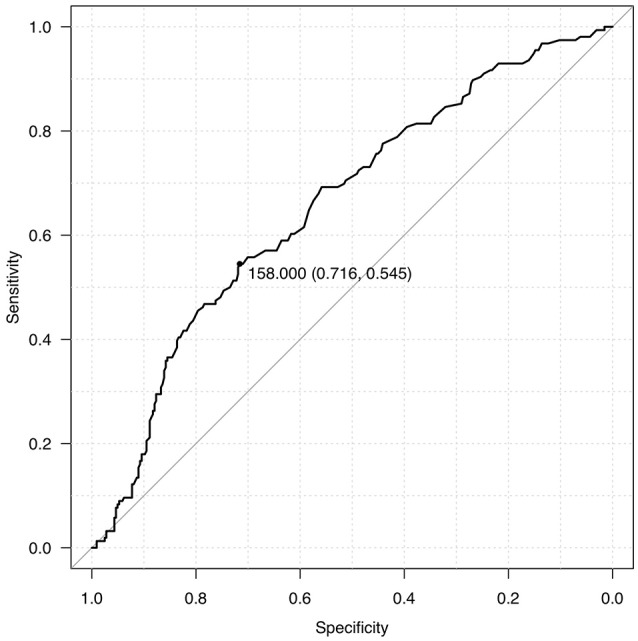
ROC curve for blood glucose levels.